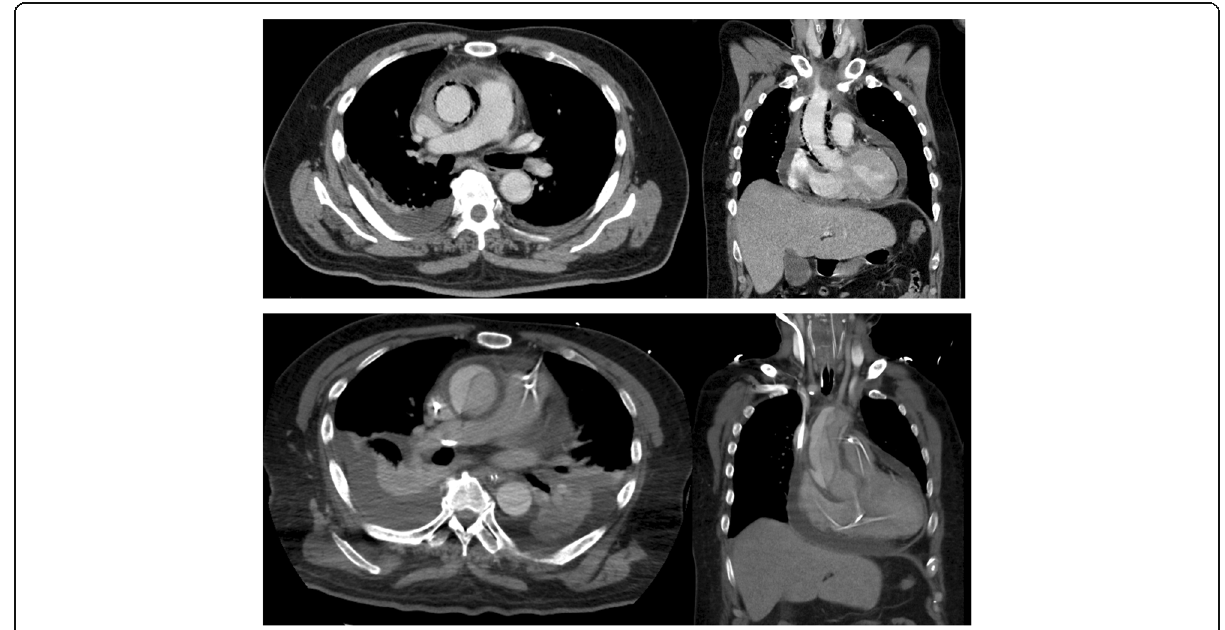
Fig. 1 Enhanced-computed tomography (CT) images on the 3rd (upper) and 5th (lower) days of